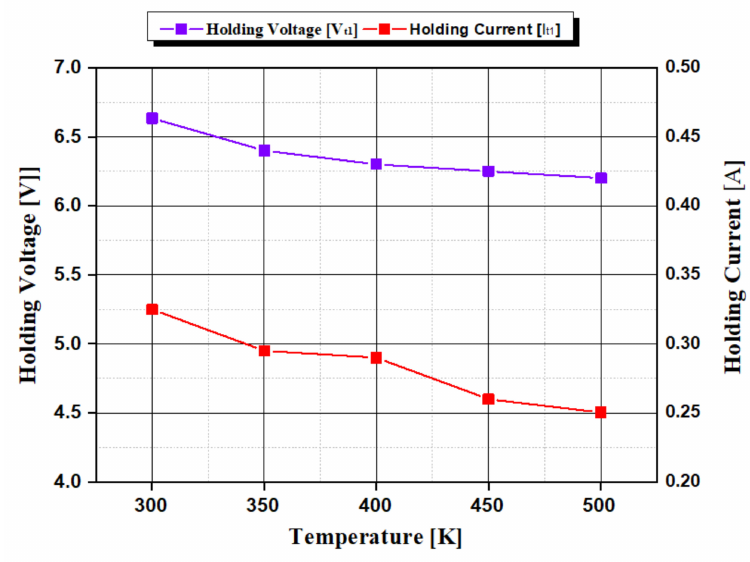
Figure 18. Holding current and voltage at high temperature (300 to 500 K).